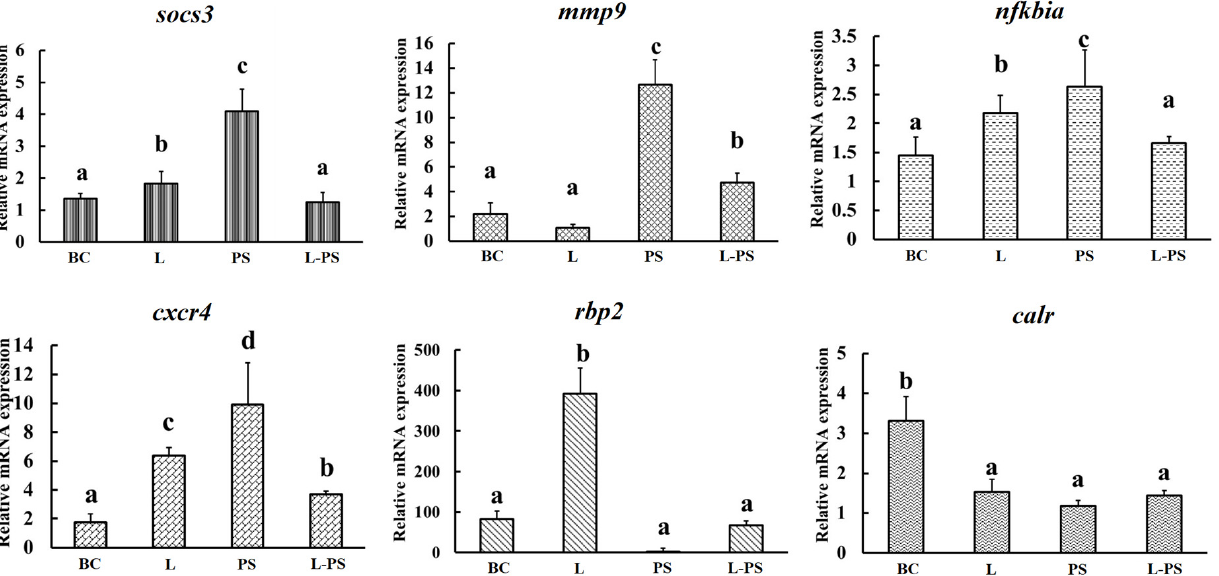
Figure 9. Validation of DEGs by qRT-PCR. BC: blank control group; L: Lactobacillus group; PS: P. shigelloides group; L-PS: Lactobacillus + P. shigelloides group; different characters (a, b, c, d) show significant difference ( p < 0.05).